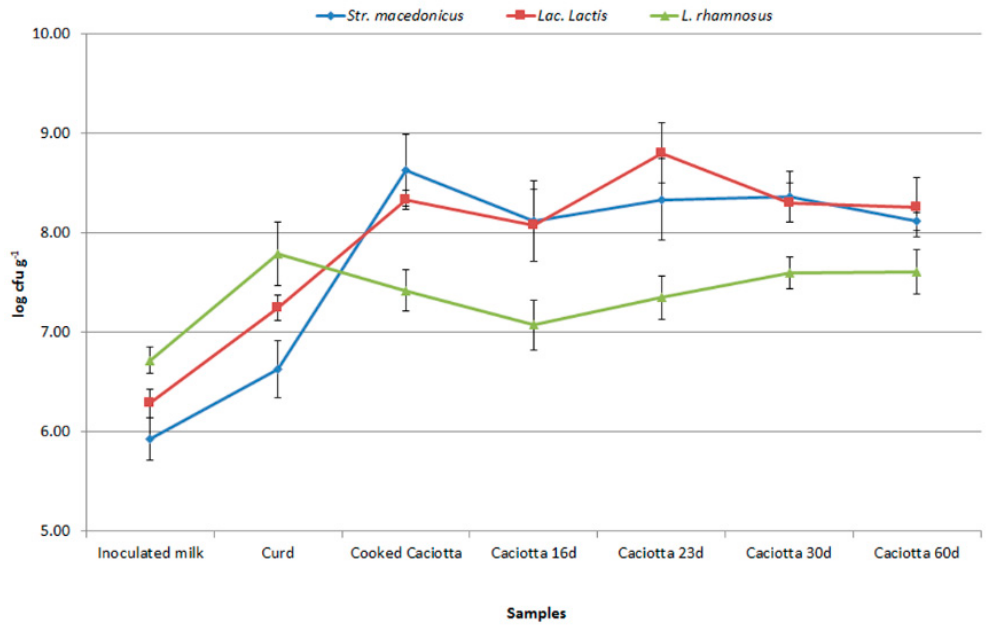
Figure 7. Population dynamics of S. macedonicus , Lactococcus spp. ASC4, and Lb. rhamnosus at different steps of production of the inoculated Caciotta.